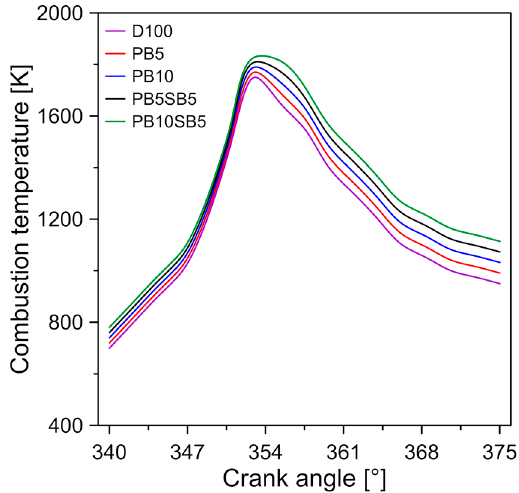
Figure 8. In-cylinder temperature in mode D.